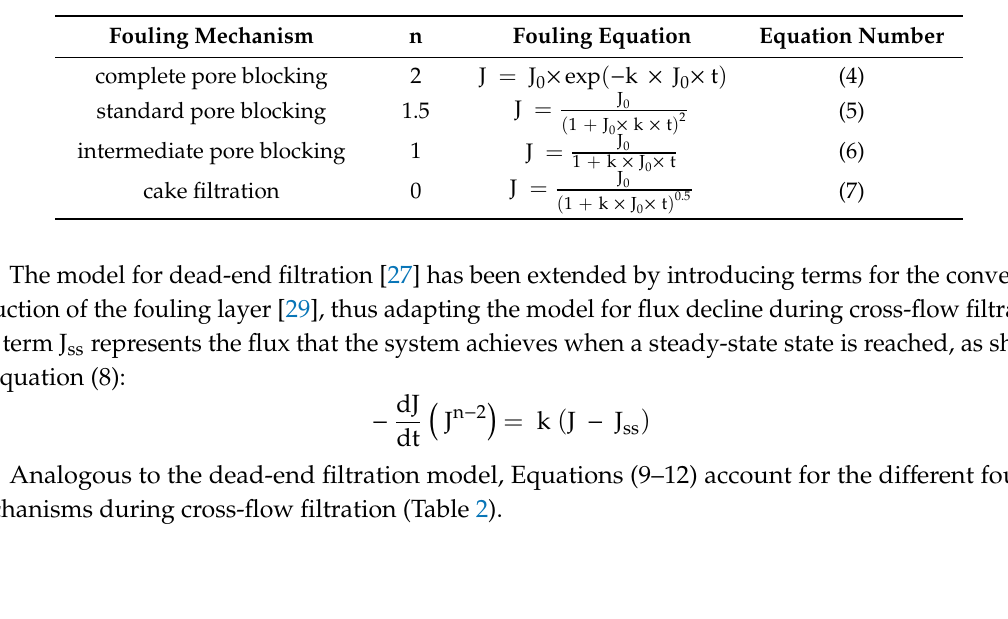
Table 1. Mathematical formulation of fouling phenomena for dead-end filtration, based on the published definitions of J 0 , n, and k